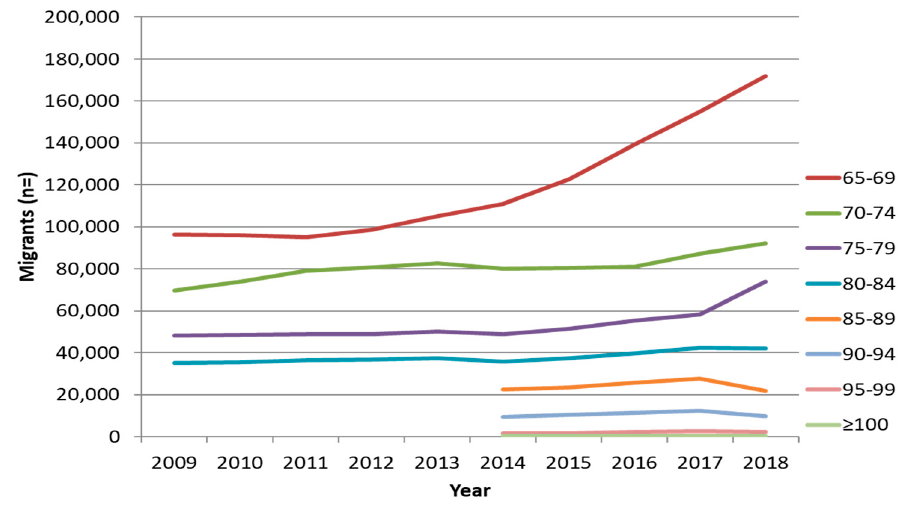
Figure 1. Number of migrant subjects living in Italy by age class [24] (credit to Marco Canevelli) .